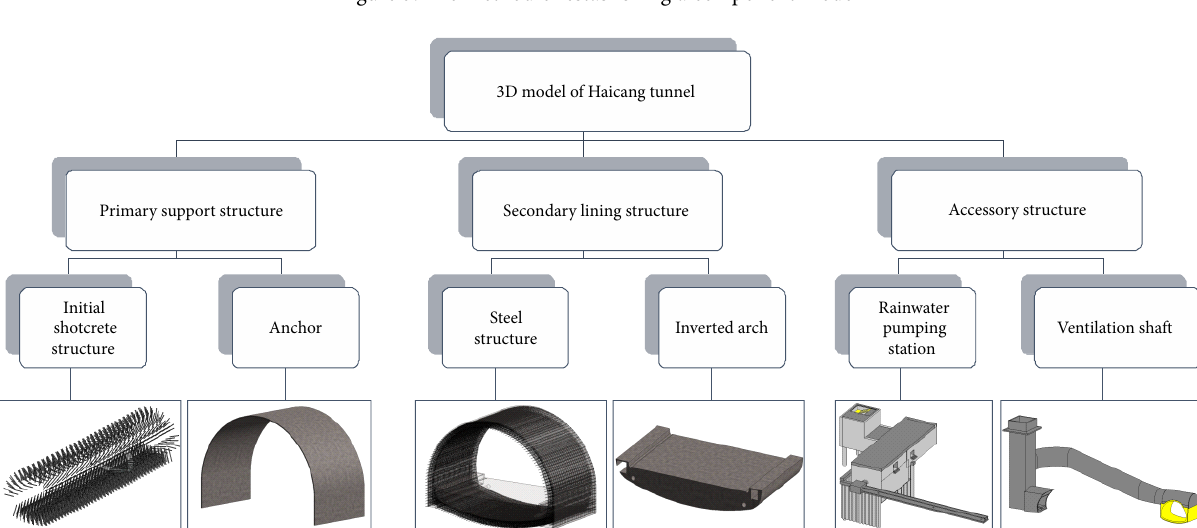
Figure 4. The component models under the classification